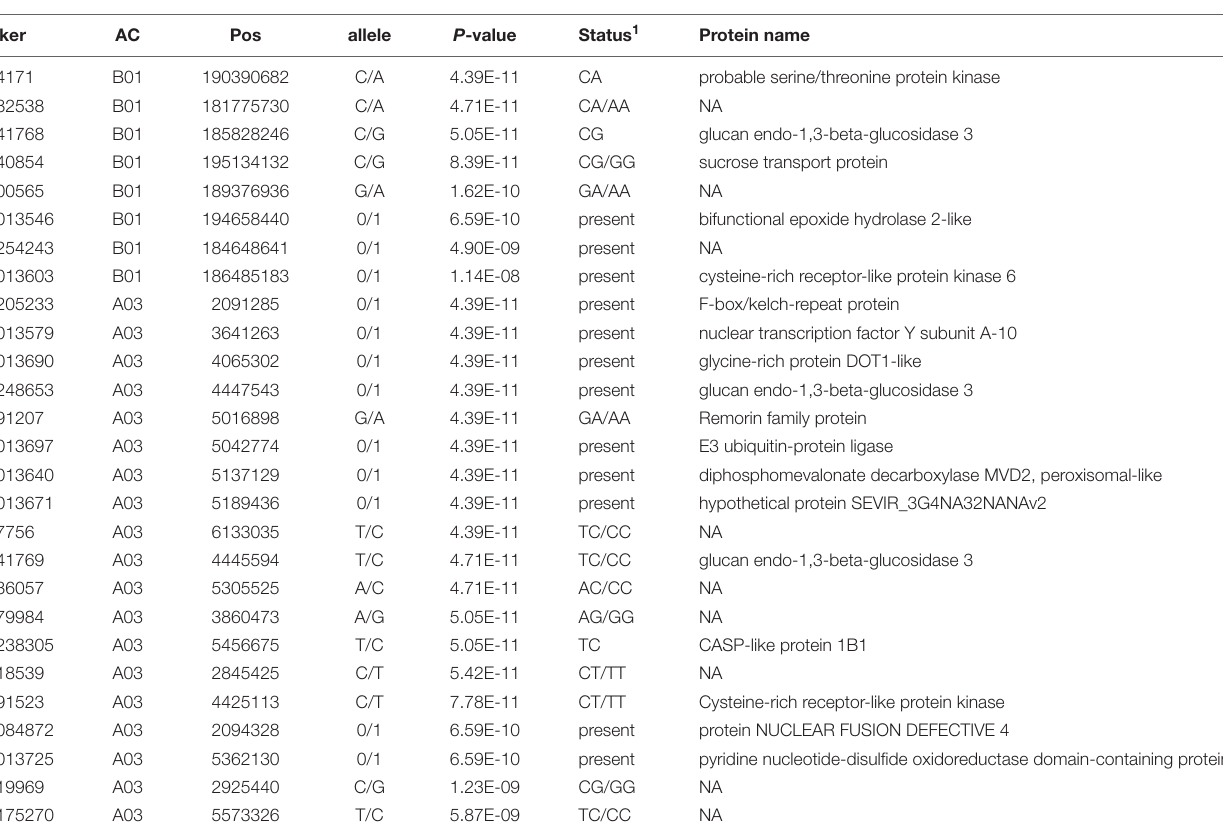
FIGURE 5 | Manhattan plot showing the association of markers with purple color (A) . Markers are on the x-axis for each of the 14-assembled chromosomes (AC). The –log10 of P values are plotted on the y -axis. The threshold level was set at P- value > the –log10 value of 7. In (B) , the LD heatmap for the pairwise LD of the markers associated with purple color. As indicated by the color key, decreasing and increasing LD is indicated by yellow and red colors, respectively. TABLE 4 | Diagnostic markers for purple